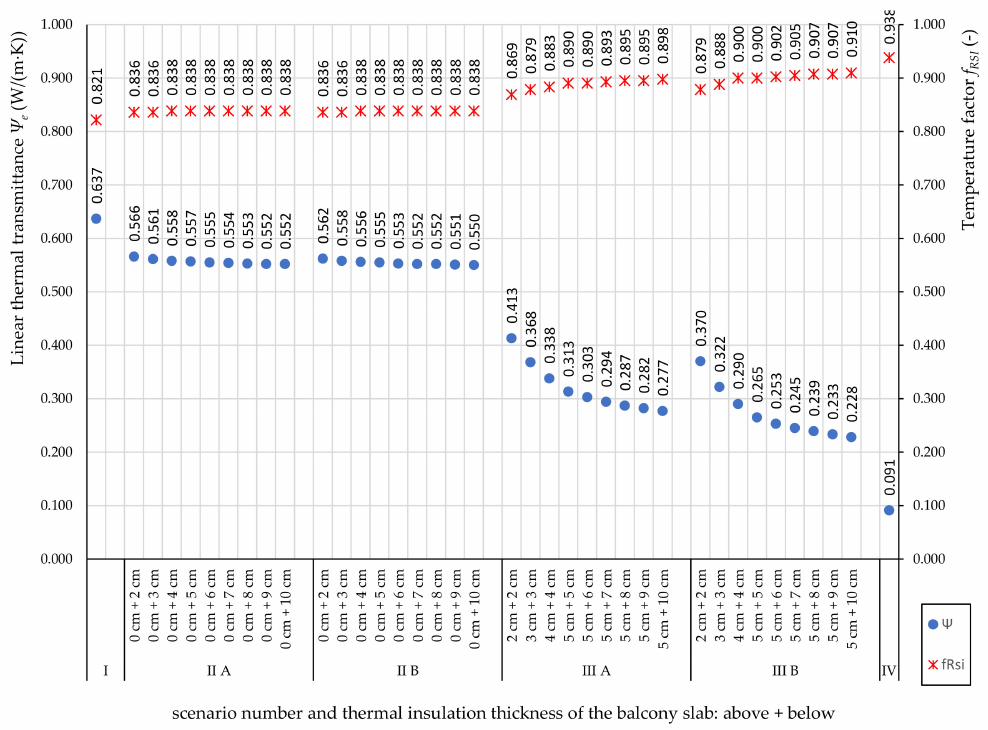
Figure 5. The linear thermal transmittance and temperature factor for the location of the building in Bialystok, when the walls of a large-panel building have been insulated with an additional 15 cm thick thermal